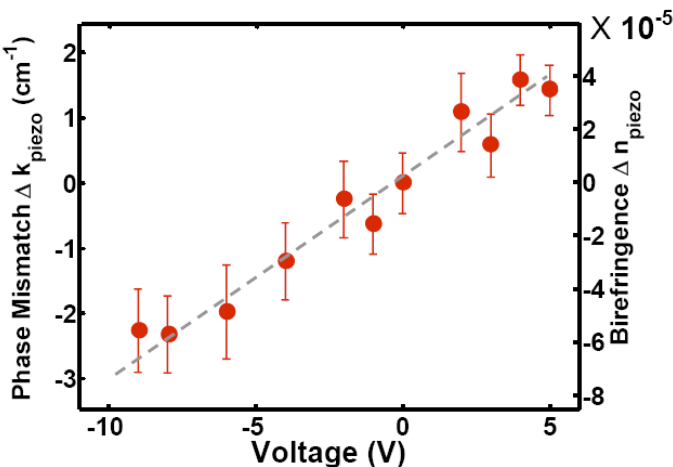
Figure 5. Dependence of phase-mismatch and birefringence of an SOI waveguide on the voltage applied to the piezoelectric manipulator. The figure is taken from [19] with courtesy of the Optical Society of